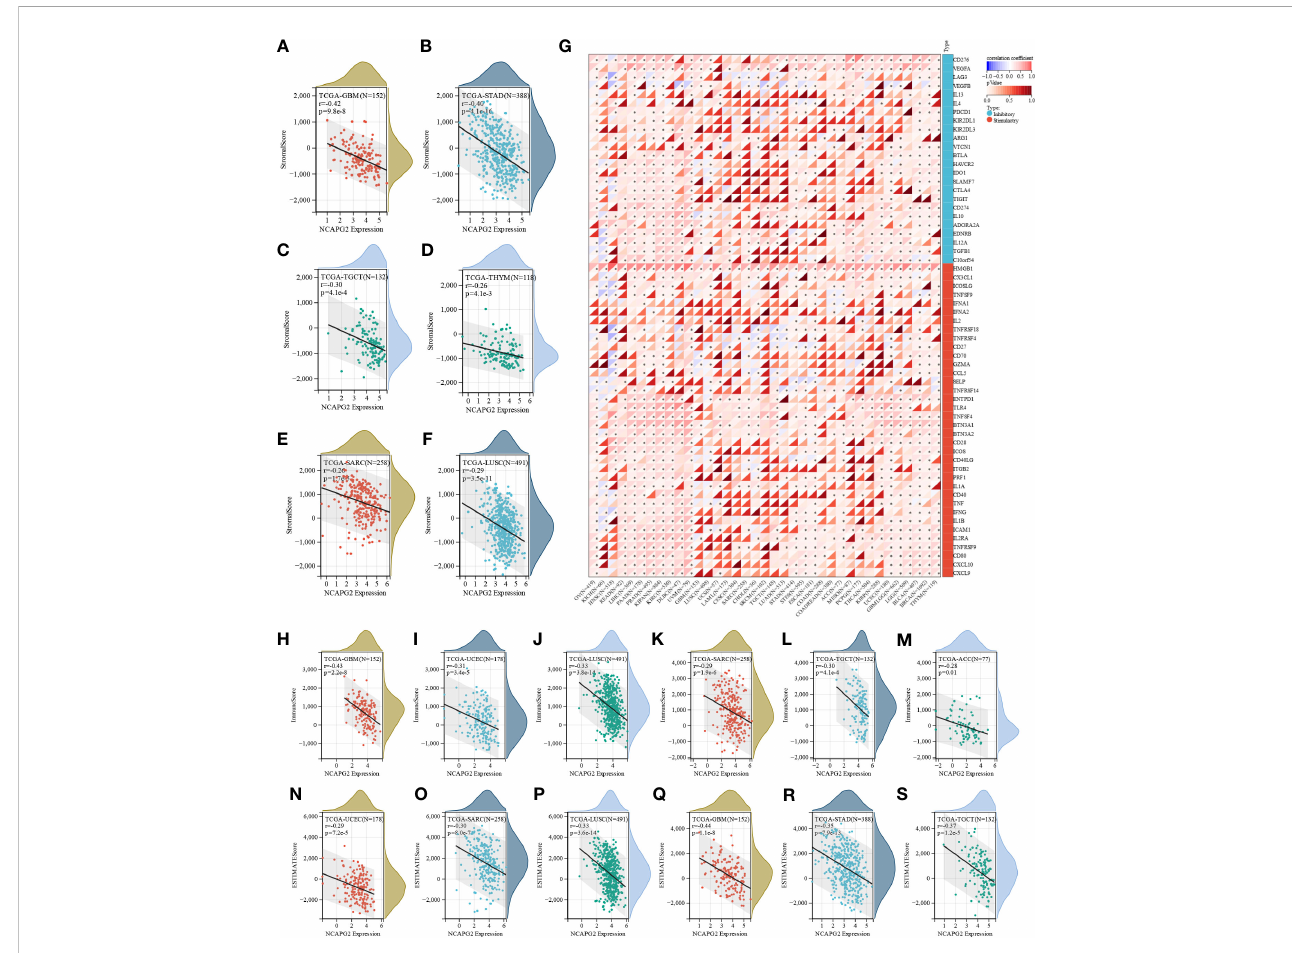
FIGURE 4 The correlation between NCAPG2 expression and immune in fi ltration and immune checkpoints. (A – F) Correlation of NCAPG2 expression with StromalScore; (G) Correlation of NCAPG2 expression with immune checkpoint-related genes; (H – M) Correlation of NCAPG2 expression with ImmuneScore; (N – S) Correlation of NCAPG2 expression with